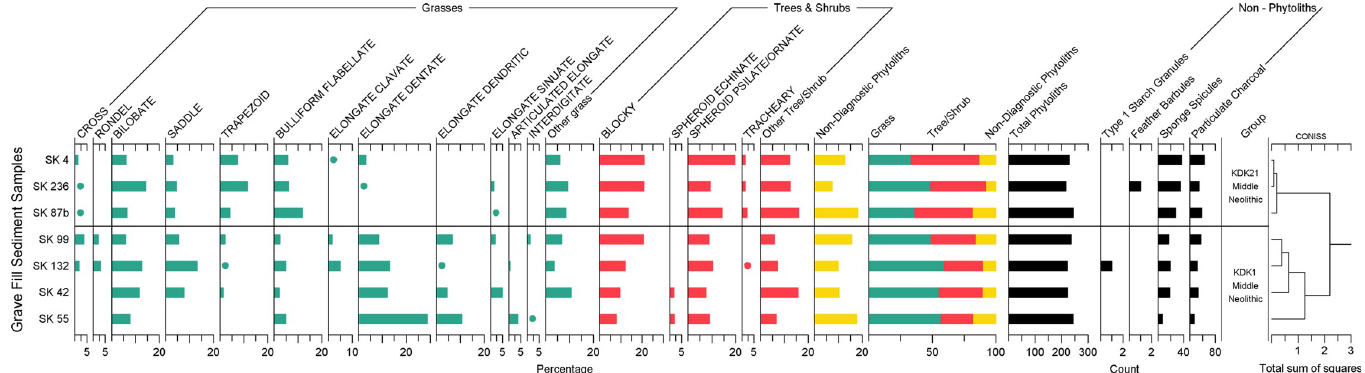
Fig 10. Summary of microparticle assemblages recovered from sediment samples from KDK1 and KDK21 Middle Neolithic grave fills. Phytolith morphotypes are presented as percentages, other microparticles are presented as counts. CONISS cluster analysis conducted on phytolith morphotype percentages only. Refer to S2 File for phytolith counts.